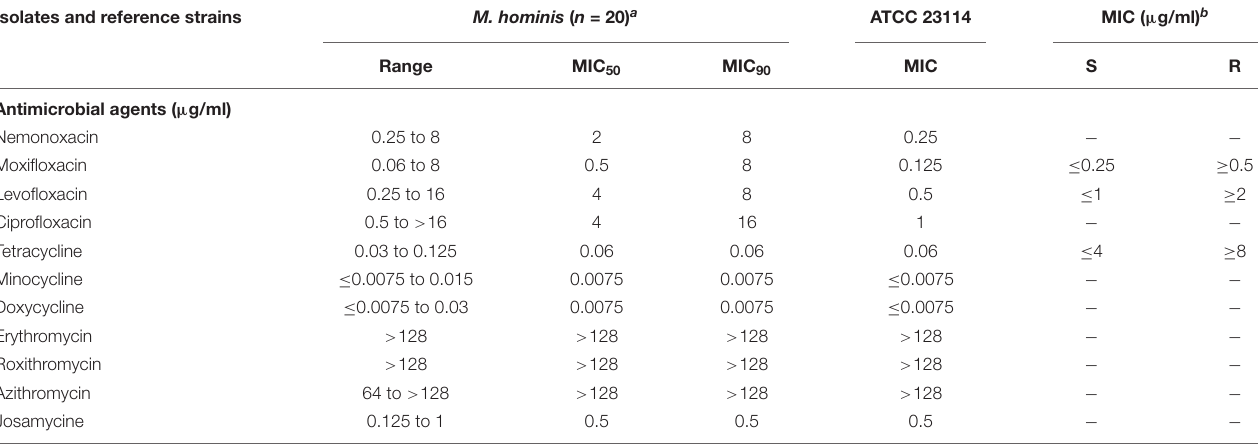
TABLE 2 | Minimal inhibitory concentration summary of nemonoxacin and comparator agents against M. hominis . Isolates and reference